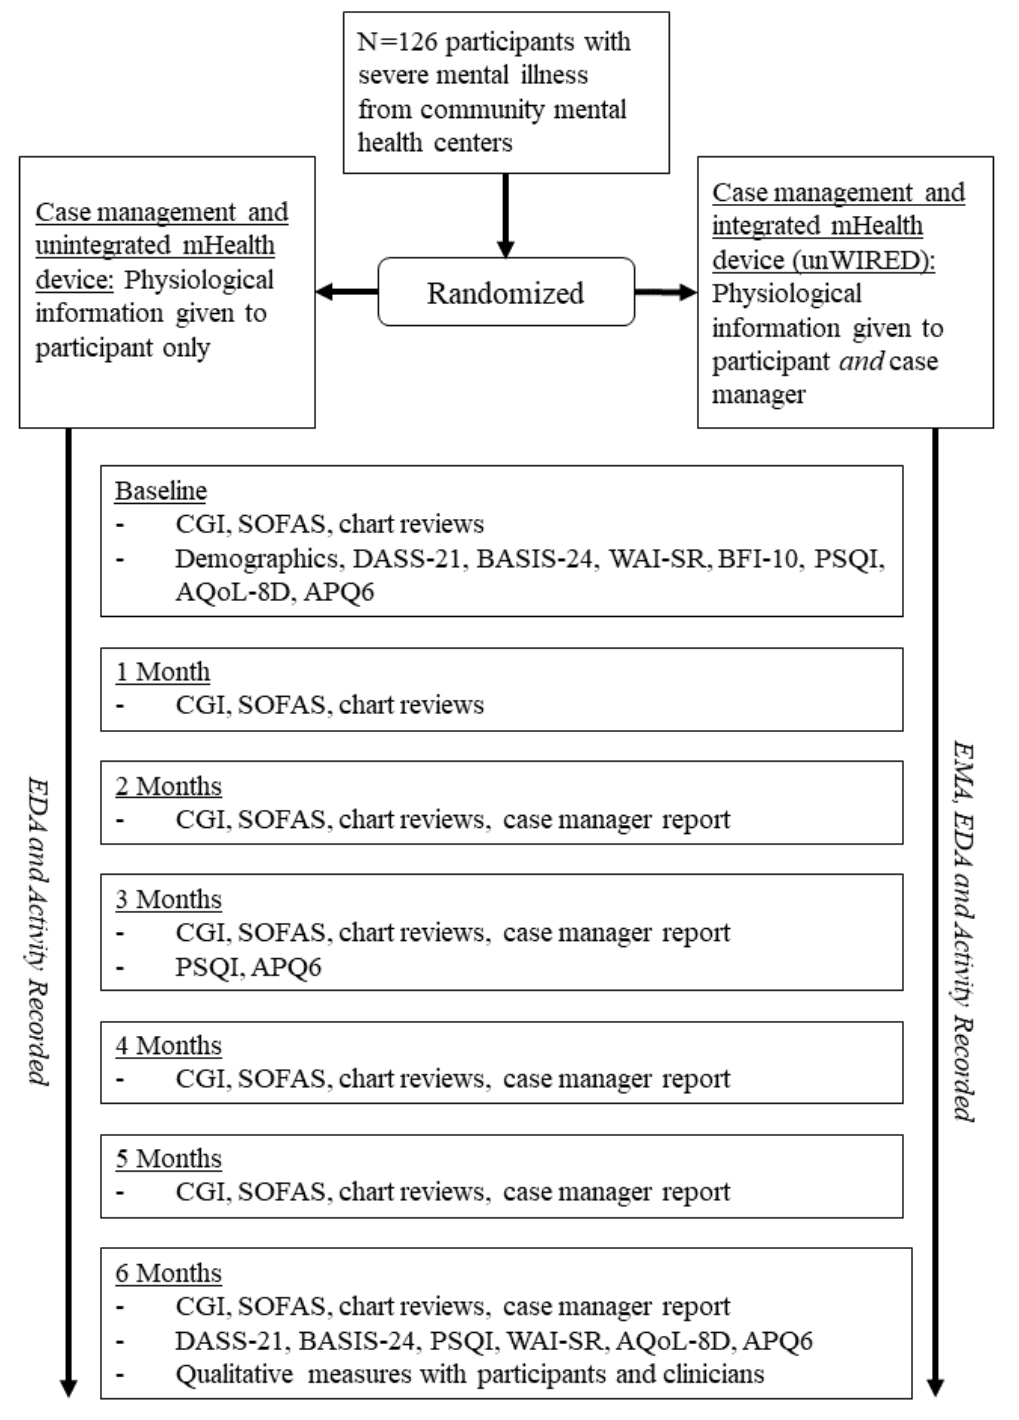
Figure 2. Outline of measurements for the randomized controlled trial. APQ6: Activity and Participation Questionnaire; AQoL-8D: Assessment of Quality of Life-8 Dimension; BASIS-24: Behaviour and Symptom Identification Scale-24; BFI-10: 10-item Big Five Inventory; CGI: Clinical Global Impression Scale; DASS-21: 21-item Depression Anxiety and Stress Scale; EDA: electrodermal activity; EMA: ecological momentary assessment; mHealth: mobile health; PSQI: Pittsburgh Sleep Quality Index; SOFAS: Social and Occupational Functioning Assessment Scale; WAI-SR: Working Alliance Inventory–Short Form